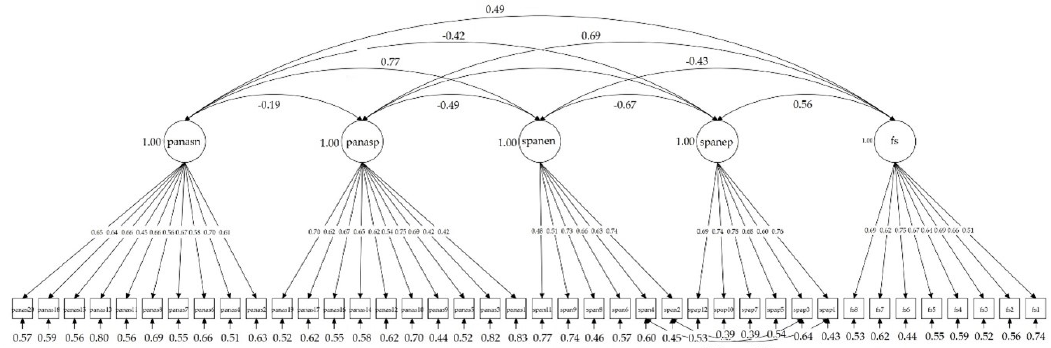
Figure 3. Path diagram for the convergent validity model with correlation coe ffi cients among latent variables and factorial loadings; panasn: Positive and Negative A ff ects Schedule (negative); panasp: Positive and Negative A ff ects Schedule (positive); spanen: Scale of Positive and Negative A ff ects (negative); spanep: Scale of Positive and Negative A ff ects (positive); fs: Flourishing Scale.